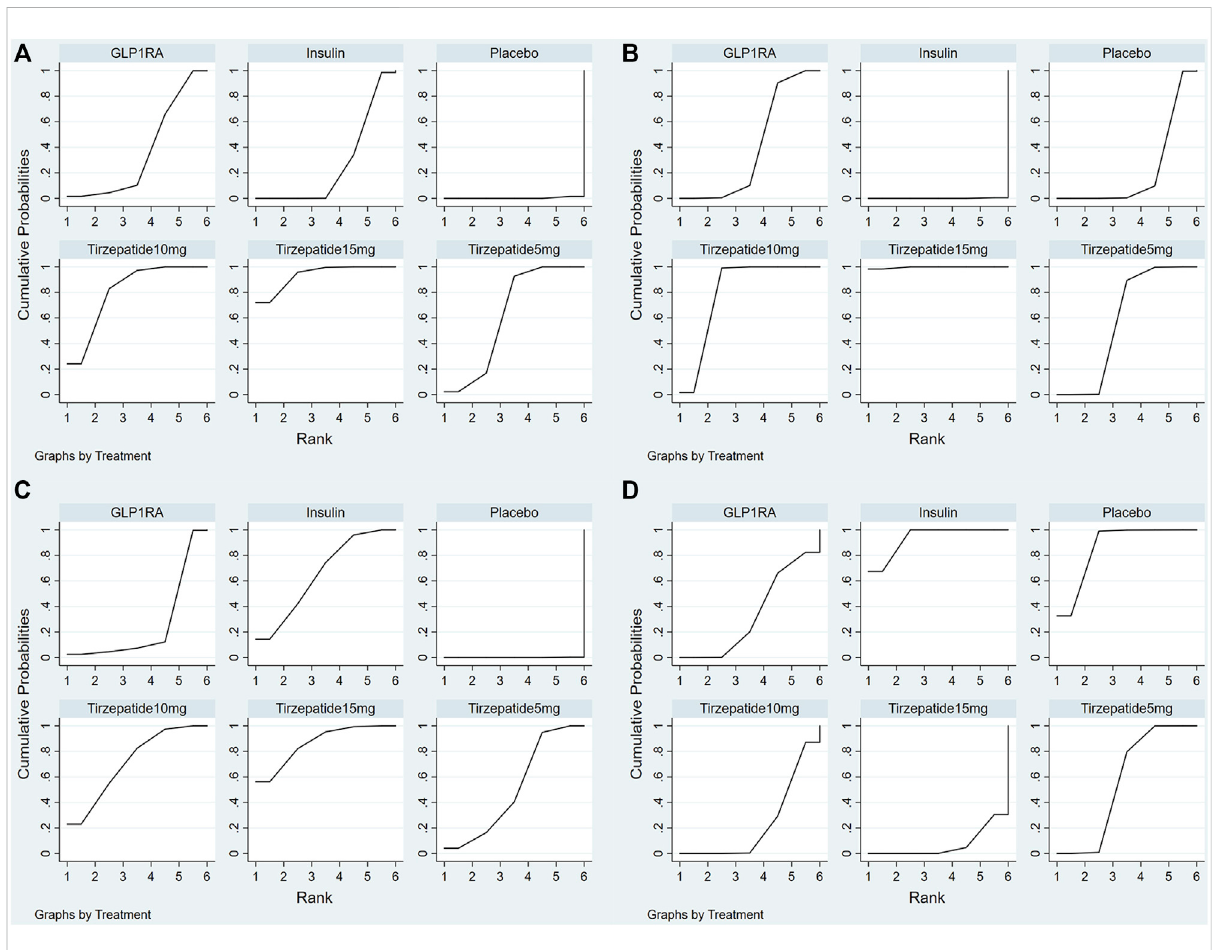
FIGURE 4 Plot of the surface under the cumulative ranking curves for outcomes. (A) HbA1c; (B) Body weight; (C) FSG; (D) gastrointestinal adverse events. Note: The surfaceunder thecumulative rankingcurve(SUCRA) was usedto estimate theranking probabilities for differenttreatments,which ranged from 0% to 100%. A better treatment is indicated by a higher SUCRA value.